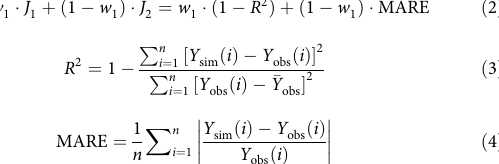
Table 4). The sensitivity of a C pool or CO 2 ef fl ux to a given parameter was assessed by the sensitivity index ( SI ) 11